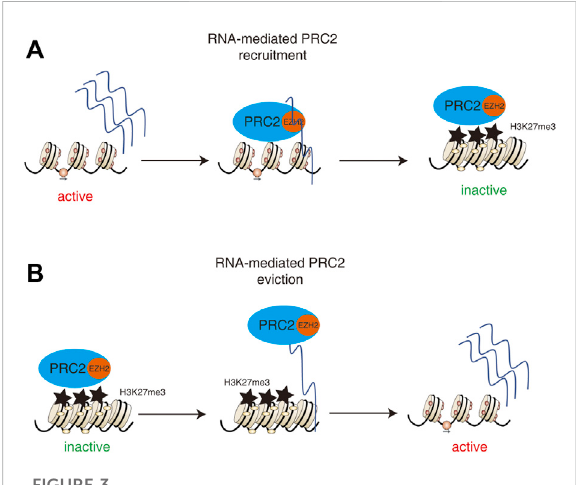
FIGURE 3 Dual roles of PRC2-RNA interactions in regulating gene expression. (A) Thepre-mRNA andlncRNAsinactivatedexpressed gene regions could recruit PRC2 and then deposits the repressor marker H3K27me3 onto the targets in order to repress the gene expression. Therefore, the transcriptionally activated regions can be silenced by PRC2 after the cell fate changed. (B) The interaction of PRC2 with RNA or chromatin is mutually antagonistic such that the interaction of PRC2 with pre-mRNA or lncRNAs can remove the binding of PRC2 from the genome and promote gene